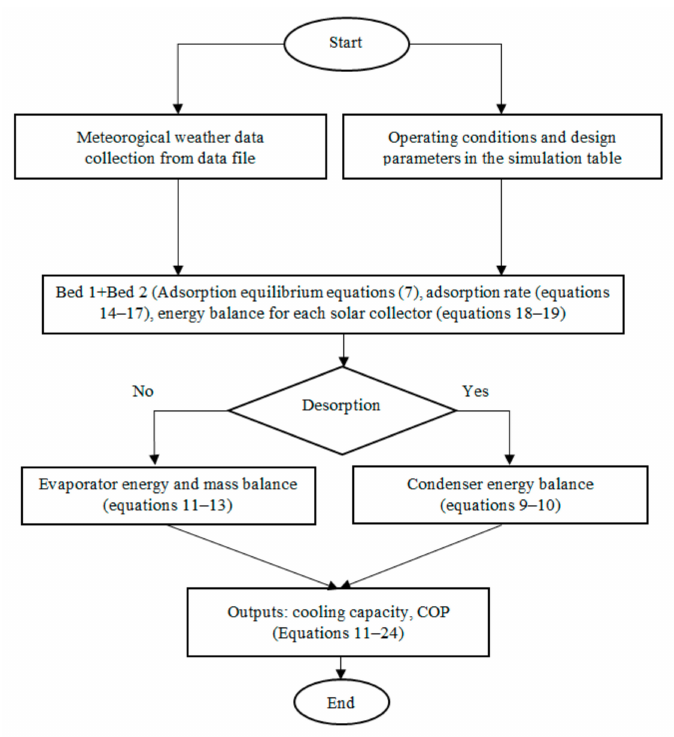
Figure 2. Flow chart of the solar adsorption chiller system simulation. Table 1. Operating conditions and design